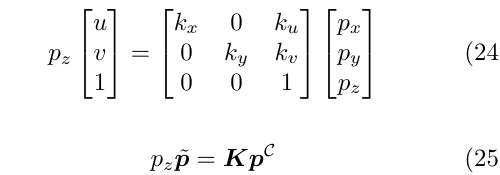
Figure 3: The modules comprising the control system. The modules in the blue box are running at the frame rate determined by the cameras. The modules in the red box are running at the fixed rate required by the robot manipu- lator (125 Hz for